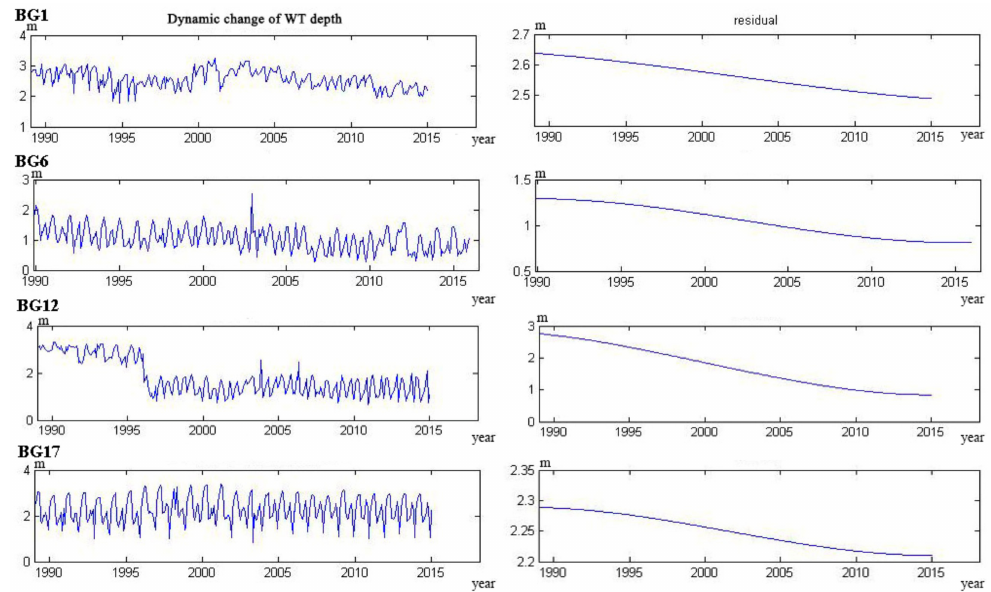
Figure 7. Empirical Modal Decomposition of the first type of curve.